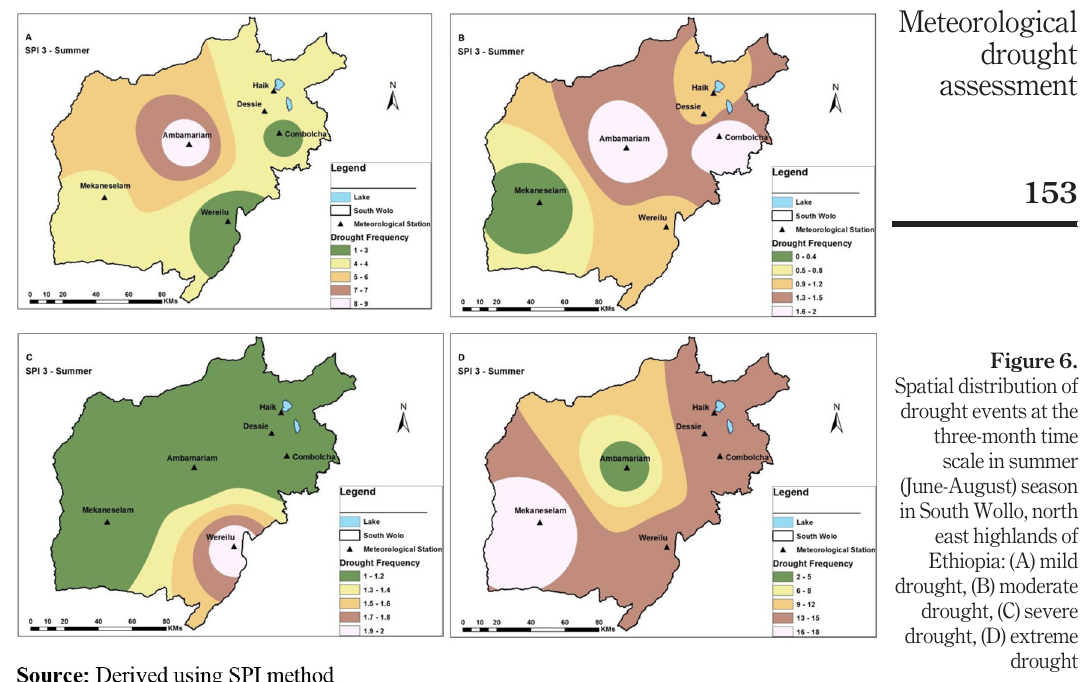
Figure 6. Spatial distribution